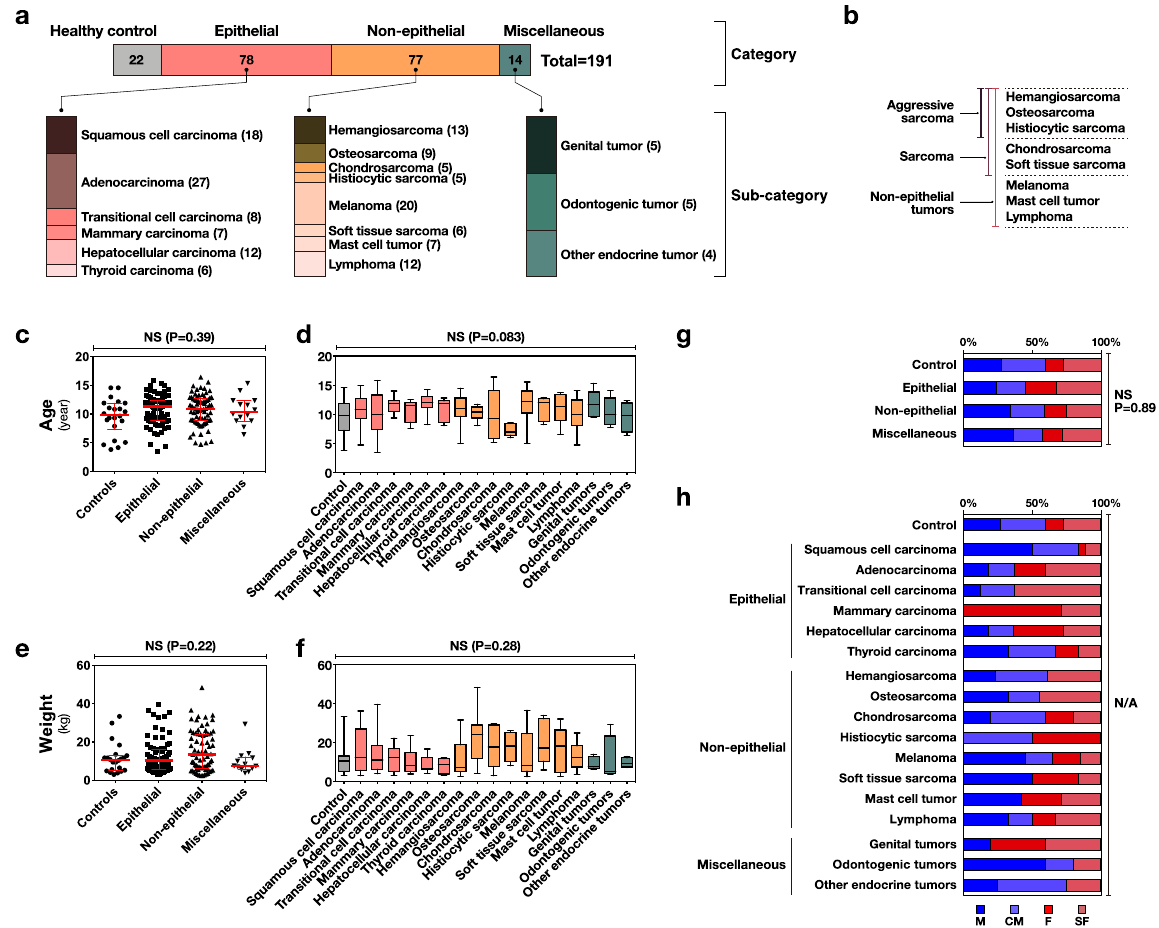
Figure 1. Summarised characteristics of the dogs used in this study. No obvious bias was observed with respect to age, weight, or gender of the dogs enrolled in this study. (a) Summary and case counts of the total 191 dogs enrolled into this study. Samples were categorised into 4 categories and 17 subcategories. (b) Classification used in this study for non-epithelial tumours (c) Swarm plot of ages (years) for the 4 categories (Kruskal-Wallis test). (d) Swarm plot of ages (years) between subcategories (Kruskal-Wallis test). (e) Swarm plot of weights (kg) between 4 categories. (Kruskal-Wallis test) (f) Swarm plot of weights (kg) between subcategories. (Kruskal- Wallis test) (g) Genders of 4 categories (Chi-square Test). (h) Genders of subcategories. Only mammary carcinoma cases had no male ones. Statistical analysis was not available (N/A) due to the limited